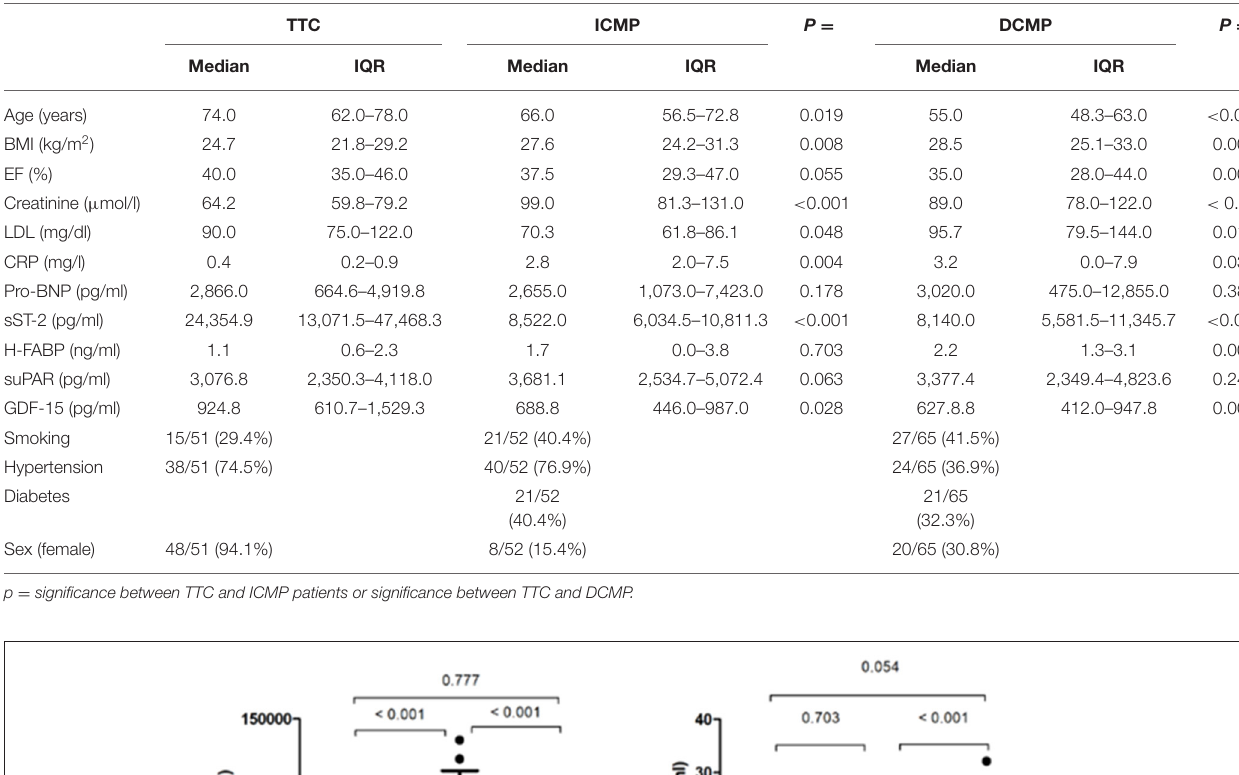
TABLE 1 | Baseline characteristics patients suffering from TTC or ICMP and DCMP, given as median and IQR.